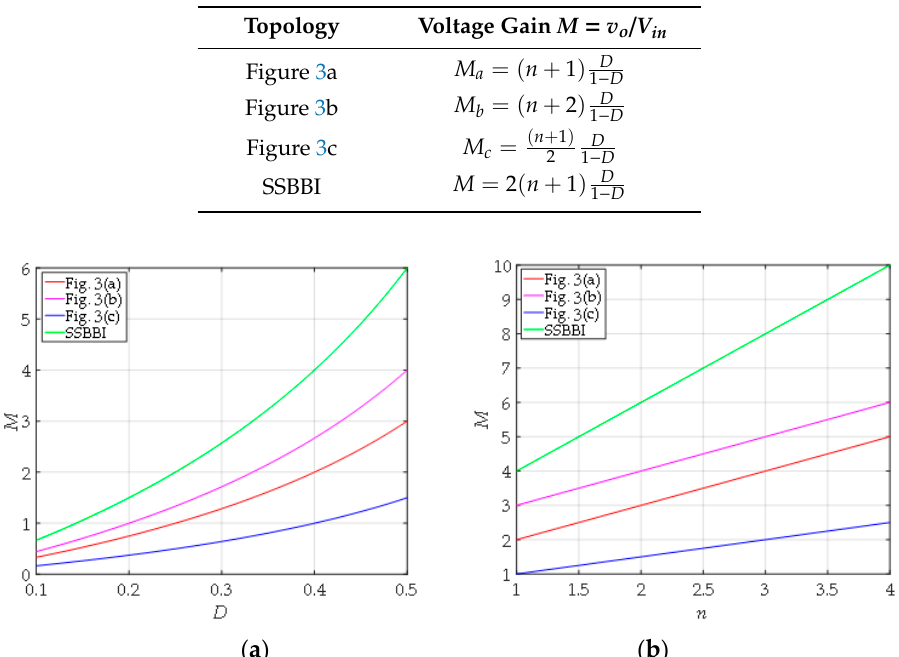
Table 5. Comparison of the voltage conversion ratio of the proposed topologies.